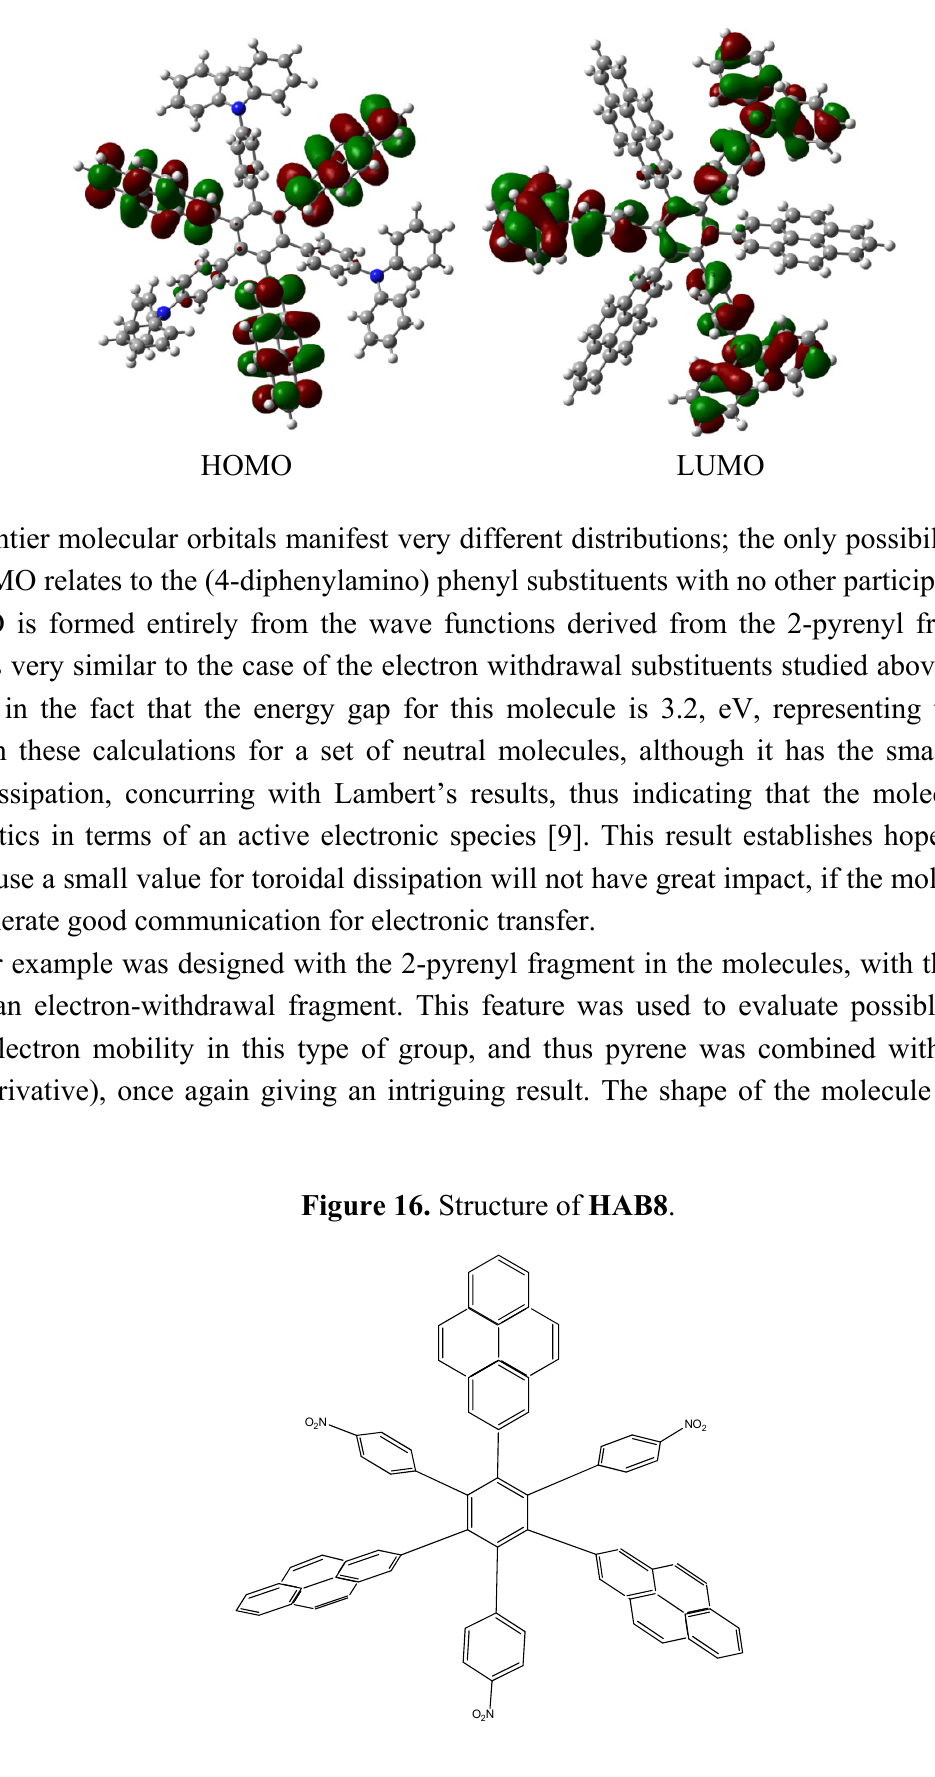
Figure 15. Frontier molecular orbitals for HAB7 .